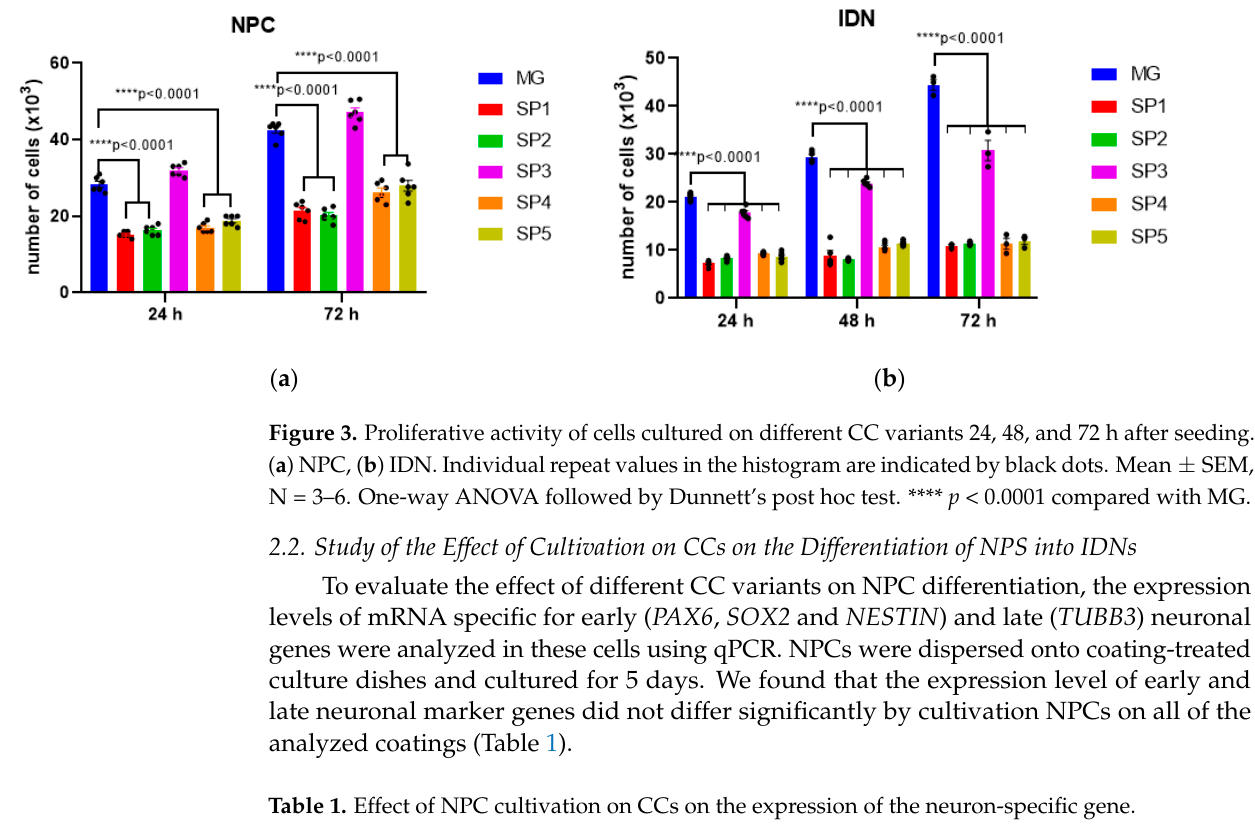
Table 1. Effect of NPC cultivation on CCs on the expression of the neuron-specific gene.